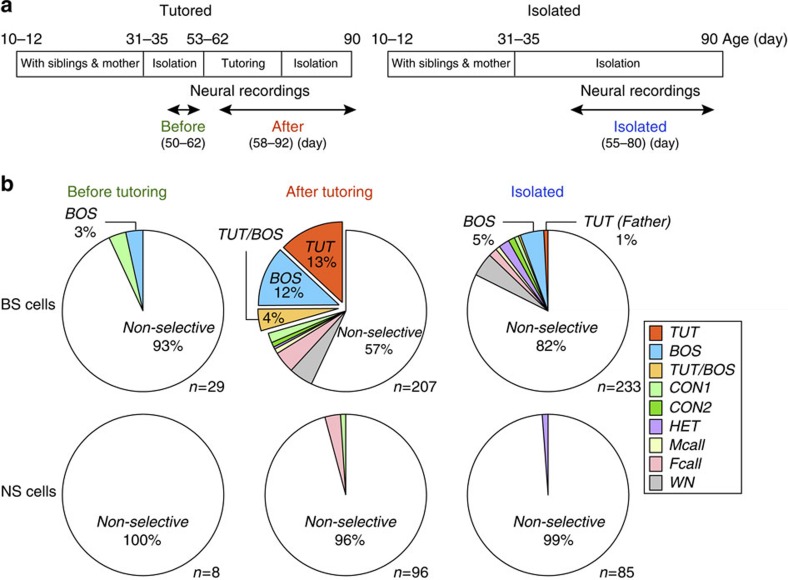
Song-selective neurons emerge after tutoring.(a) Timeline of the experimental schedule. (b) Percentages of
neurons selective for each sound stimulus among BS (top) and NS (bottom)
neurons recorded from before tutored (left), after tutored (middle), and
isolated birds. Proportion of TUT-selective BS cells in the three groups
(before, after and isolated) were significantly different
(χ2-test, P<0.001). BOS,
bird's own song; CON1, conspecific song-1; CON2, conspecific song-2;
Fcall, female call; HET, heterospecific song; Mcall, male call; TUT, tutor
song; WN, white noise.